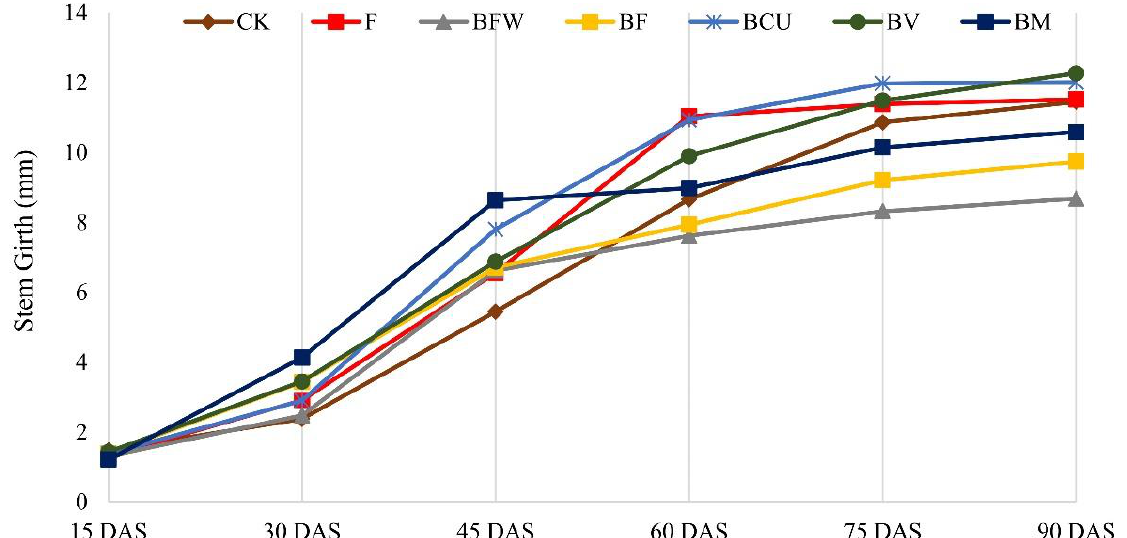
Figure 2. Effects of various biochar-blended or enriched organic and inorganic treatments on plant stem girth recorded at every 15 d interval from 15 DAS to 90 DAS.